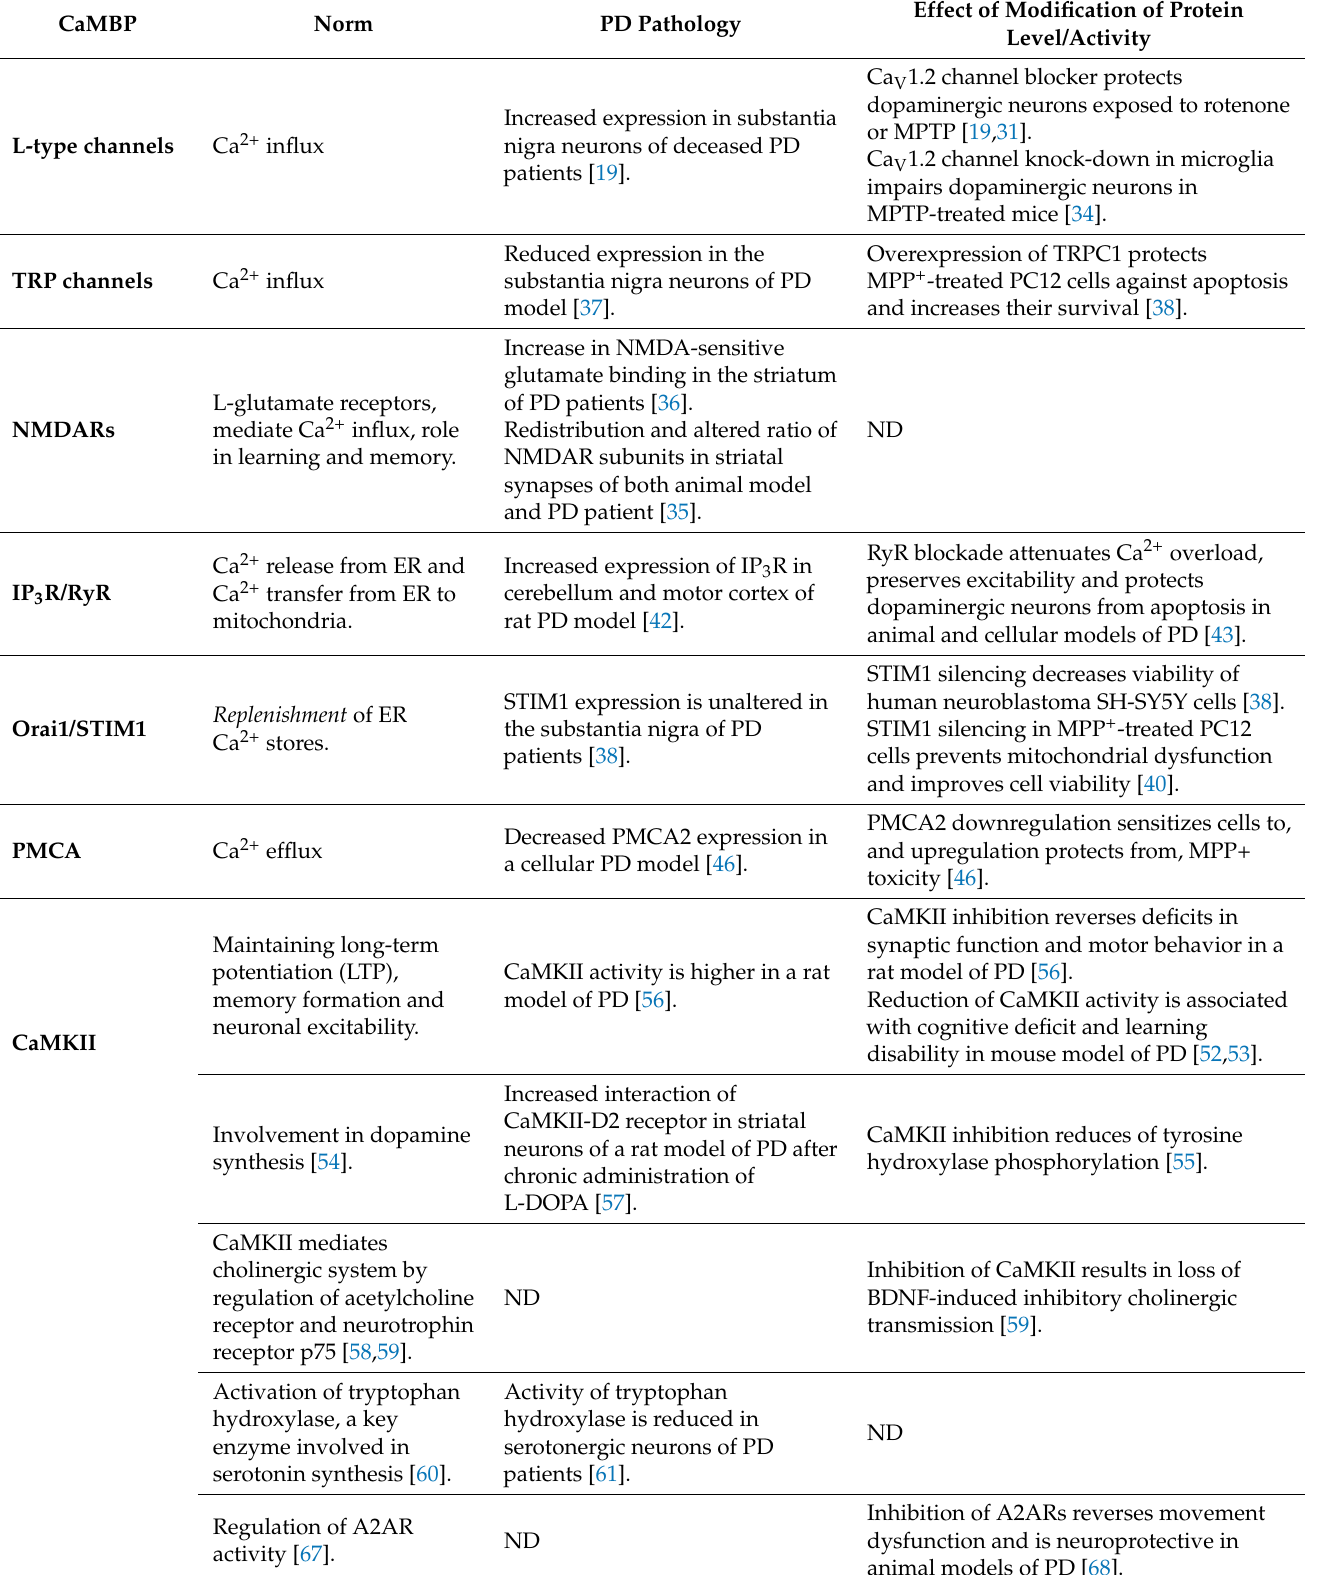
Table 1. Calmodulin binding proteins (CaMBPs) and their function in norm and